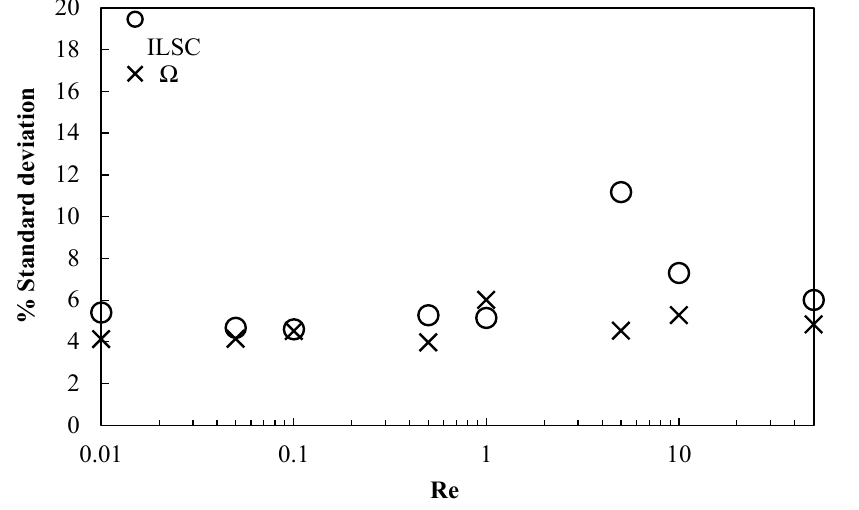
Figure 12. Standard deviation at the channel outlet of the three micromixer designs (200 µm channel width).